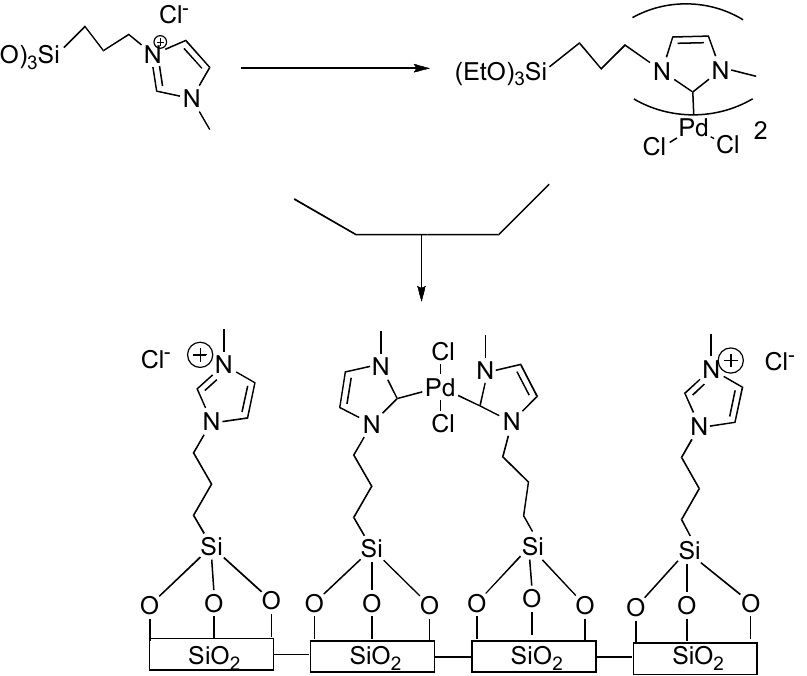
Figure 19. PEG supported